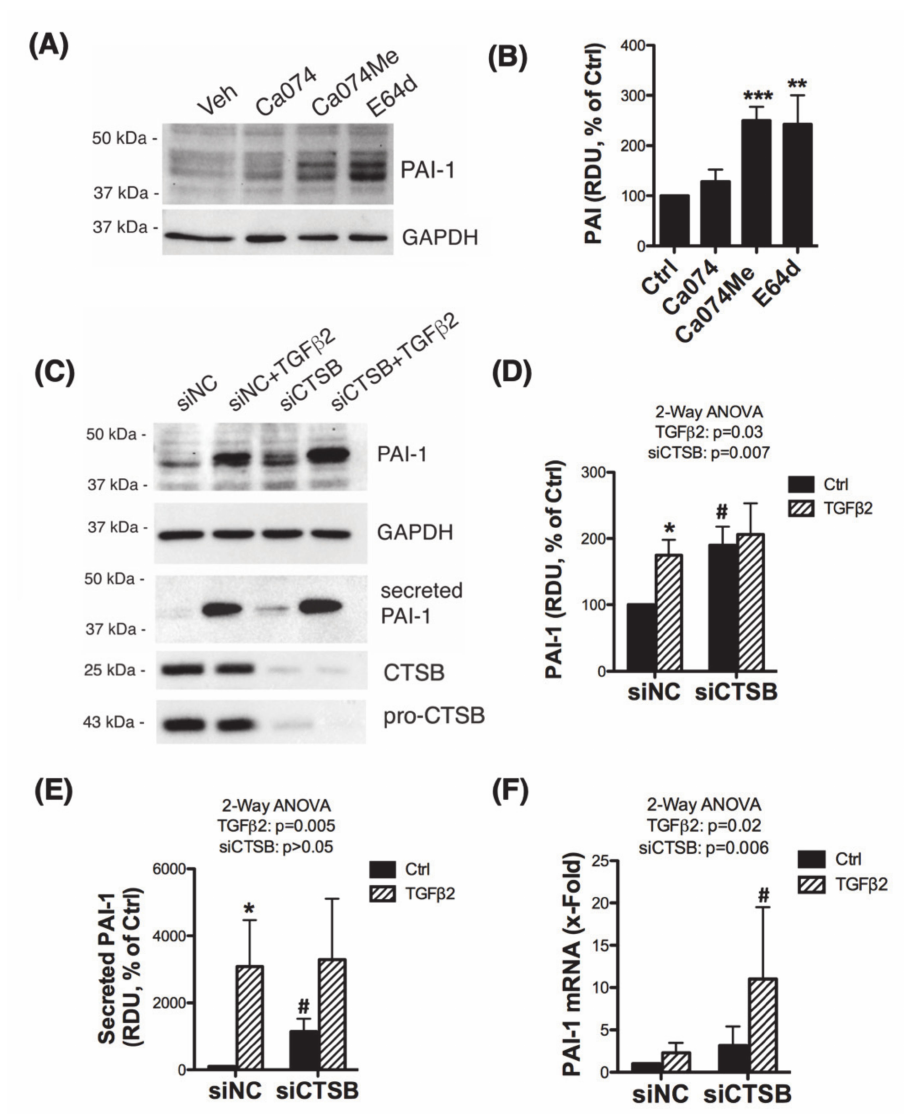
Figure 3. CTSB inhibition increases production and secretion of PAI-1. ( A ) Protein levels of PAI-1 evaluated by WB in whole cell lysates (5 µ g) from primary hTM cells treated with Ca074 (40 µ M), Ca074Me (40 µ M), and E64d (10 µ M) for 24 h. Relative PAI-1 protein levels calculated from densito- metric analysis of the bands are represented in ( B ). Data are shown as the mean ± S.D. ** p < 0.01; *** p < 0.001, t -test, n = 3. ( C ) Protein levels of PAI-1 evaluated by WB in whole cell lysates (5 µ g) and culture media (15 µ L) from primary hTM cells transfected for 72 h with siCTSB followed by TGF β 2 treatment (10 ng/mL, 48 h). Relative PAI-1 protein levels calculated from densitometric analysis of the bands are represented in ( D , E ). Data are shown as the mean ± S.D. * p < 0.05 2-way ANOVA with Tukey comparison tests, n = 3. ( F ) mRNA expression levels of PAI-1 in siCTSB-transfected TGF β 2-treated hTM cells calculated by qPCR. Data are shown as the mean ± S.D. p < 0.05 2-way ANOVA with Tukey comparison tests, n = 3. * compares TGF β 2-treated to non-treated controls; # compares siCTSB to